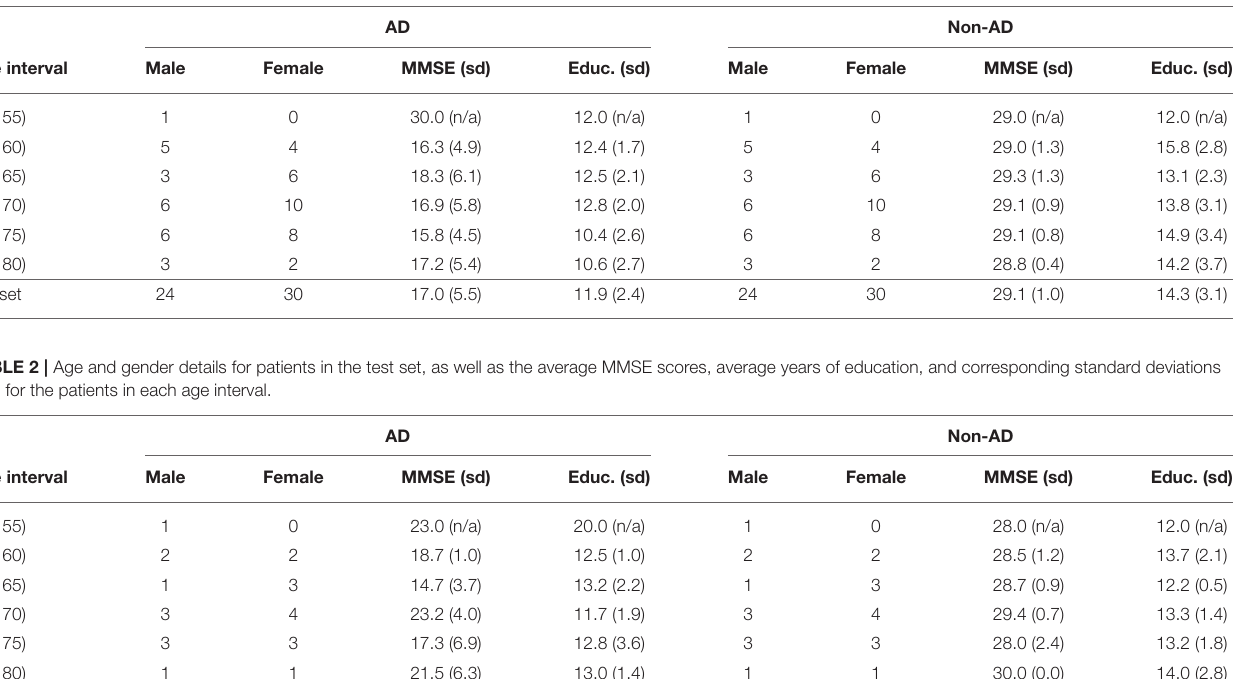
TABLE 1 | Age and gender details for patients in the training set, as well as the average MMSE scores, average years of education, and corresponding standard deviations (sd), for the patients in each age interval. AD Non-AD